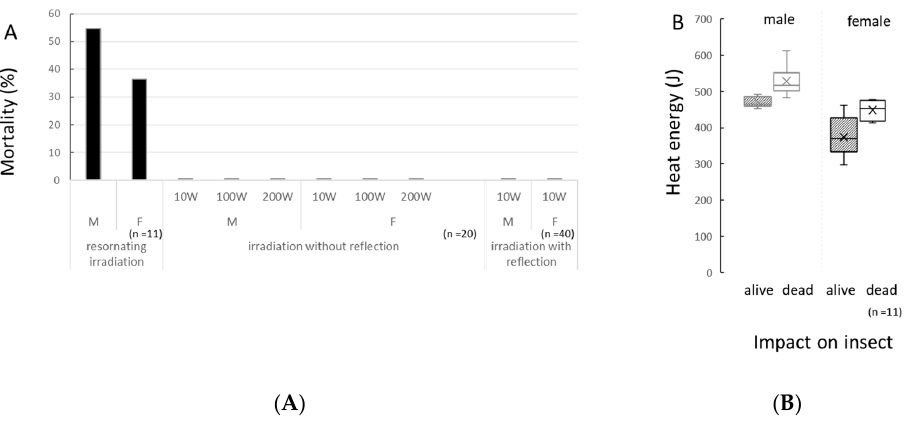
Figure 1. Effect of different energy transduction patterns on the Drosophila body under three irradiation conditions. ( A ) Mortality of adult flies under three different irradiation conditions; ( B ) Energy absorbed by an insect body, which was absorbed until the sample insect stopped moving under irradiation with resonance waves ( n = 11). The horizontal bar indicates the insect status one day after irradiation.